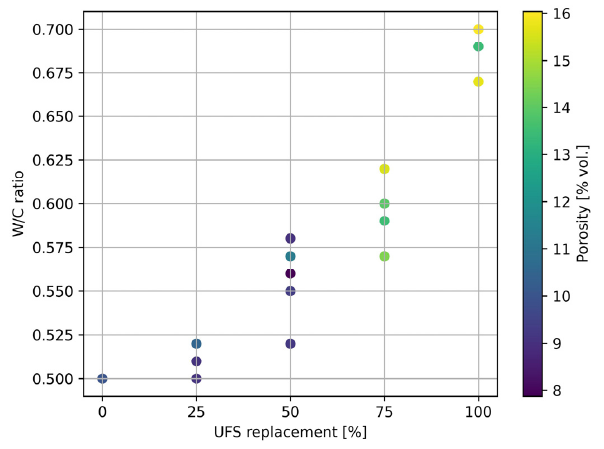
Figure 12. Accessible porosity of mortars with UFS (% vol.).